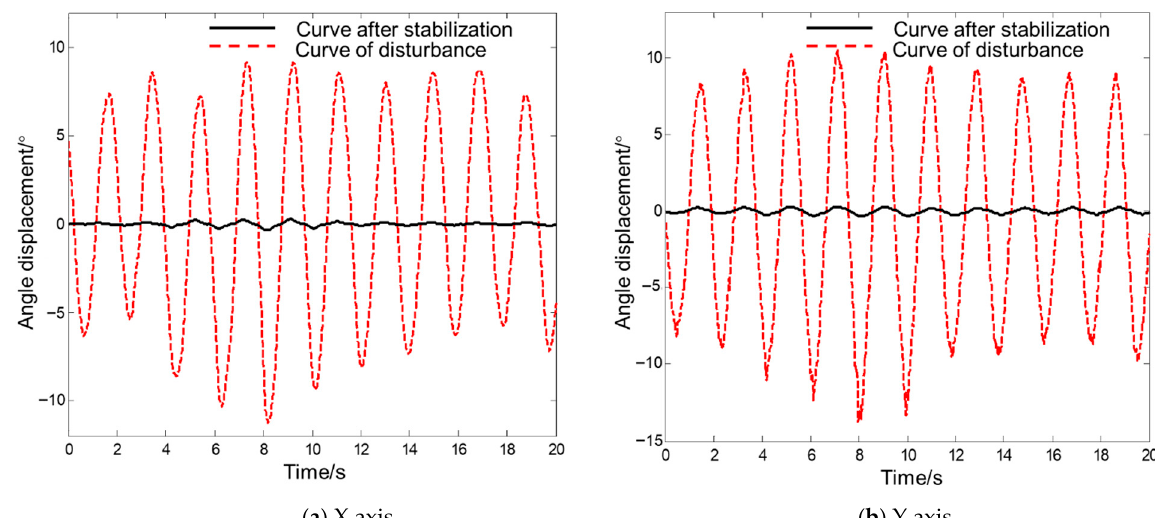
Figure 18. Leveling effect under continuous wave disturbance.